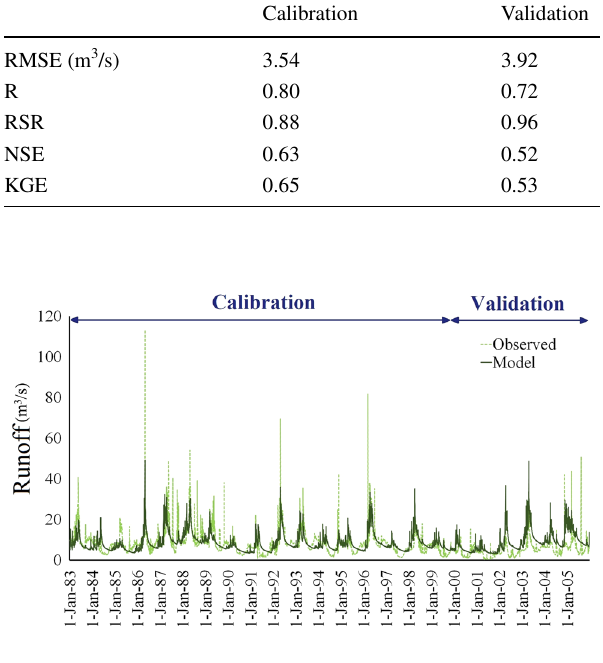
Fig. 6 Comparison of the calibration and validation periods in the IHACRES rainfall-runoff